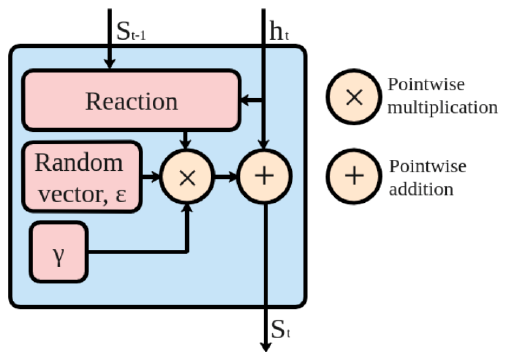
Figure 2. Stochastic module.